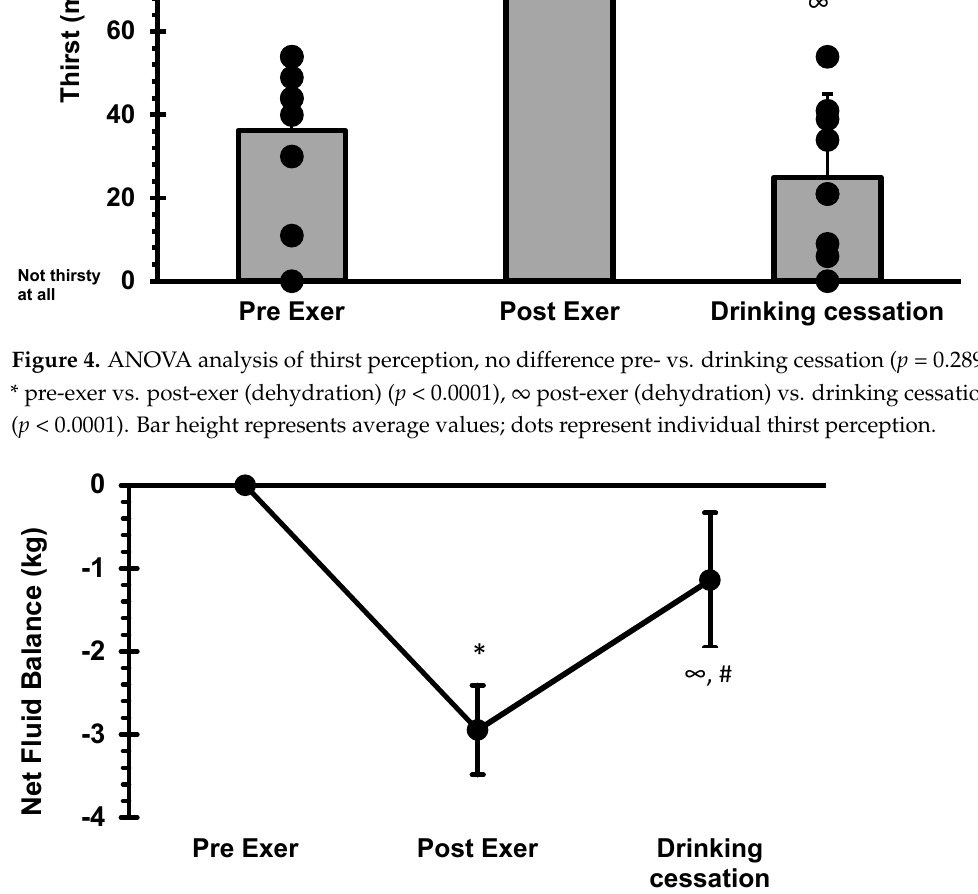
Figure 5. ANOVA analysis for net fluid balance * pre vs. post-exer ( p < 0.0001) ∞ post-exercise (dehydration) vs. drinking cessation ( p < 0.0001) # pre-exer vs. drinking cessation ( p = 0.0012). Mean ± SD. ANOVA (F = 8.44, p = 0.0017) for stomach fullness showed no difference between pre- exercise (3.1 ± 0.9) and drinking cessation point (2.1 ± 1.1; p = 0.055). Pre-exercise and post- exercise (1.3 ± 0.5) were different ( p = 0.0012), but there was no significant difference be- tween post-exercise and drinking cessation ( p = 0.251) See Figure 6.